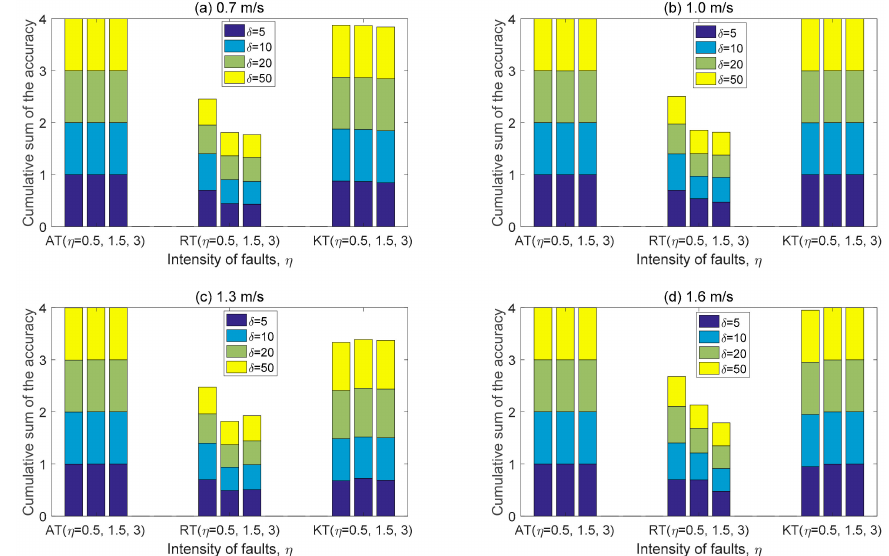
Figure 10. Accuracy according to each duration as a function of noise fault intensity: ( a ) Cumulative sum of the accuracy at 0.7 m/s of Jackal UGV; ( b ) Cumulative sum of the accuracy at 1.0 m/s; ( c ) Cumulative sum of the accuracy at 1.3 m/s; ( d ) Cumulative sum of the accuracy at 1.6